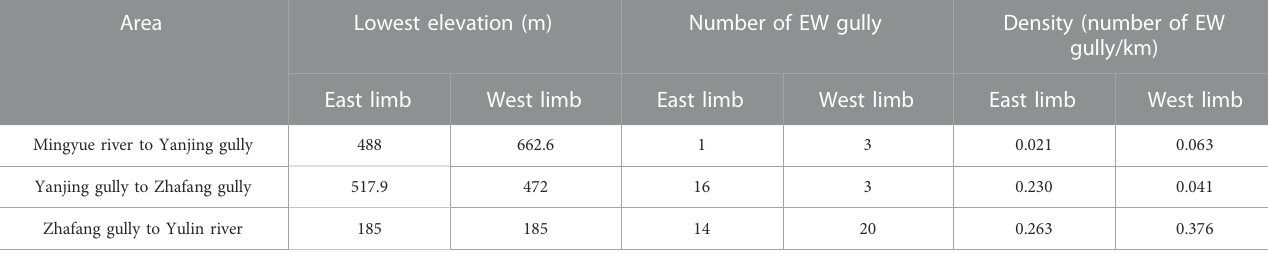
TABLE 1 Statistics of EW gullies elevation and density in Mingyueshan. Area Lowest elevation (m) Number of EW gully Density (number of EW